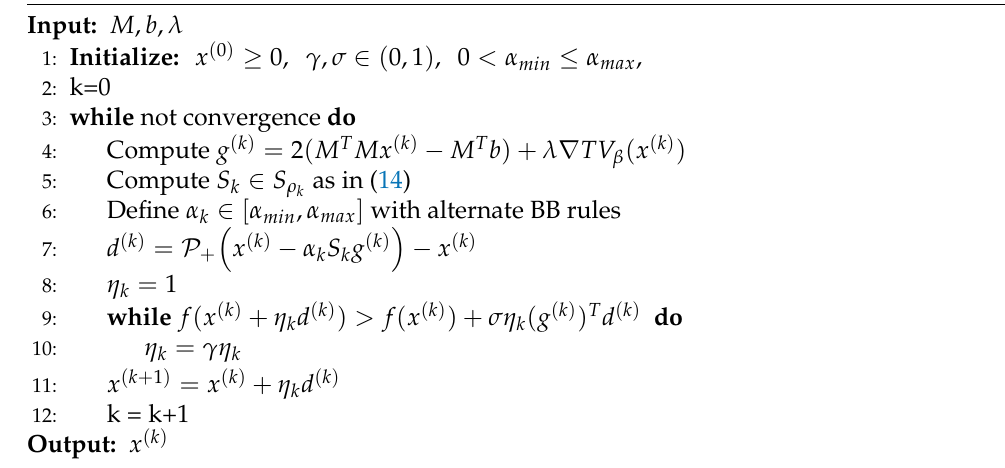
Algorithm 1 Scaled Gradient Projection algorithm